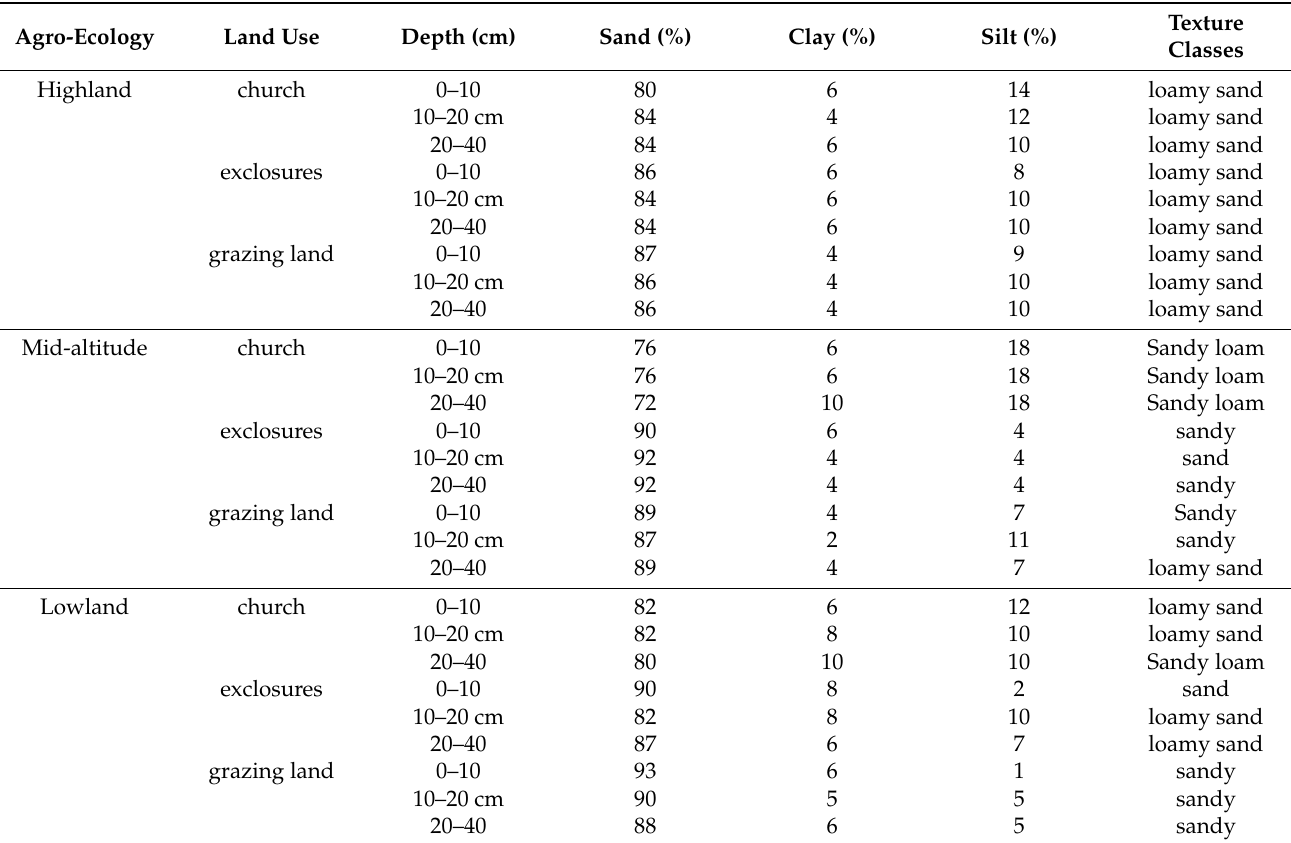
Table A3. Soil texture across different agro-ecologies, land uses, and soil